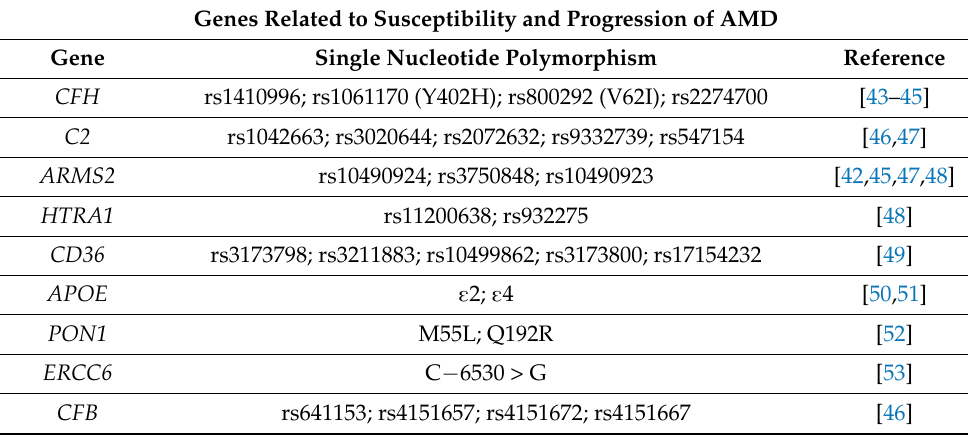
Table 1. Relevant SNPs associated with AMD susceptibility and progression. Genes Related to Susceptibility and Progression of